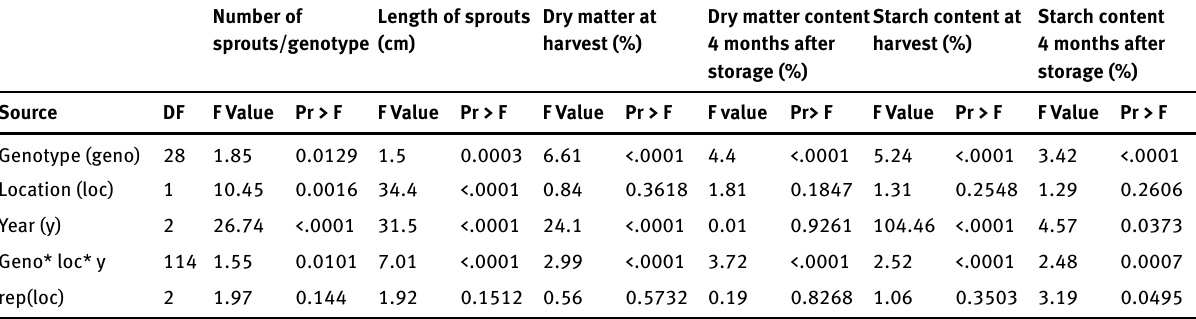
Table 3: P-values of number of sprouts per genotype, length of sprouts measured at six weeks after sprouting (cm), dry matter content at harvest and four months after storage (%) and starch content at harvest and four months after storage (%) analysed across data collected at